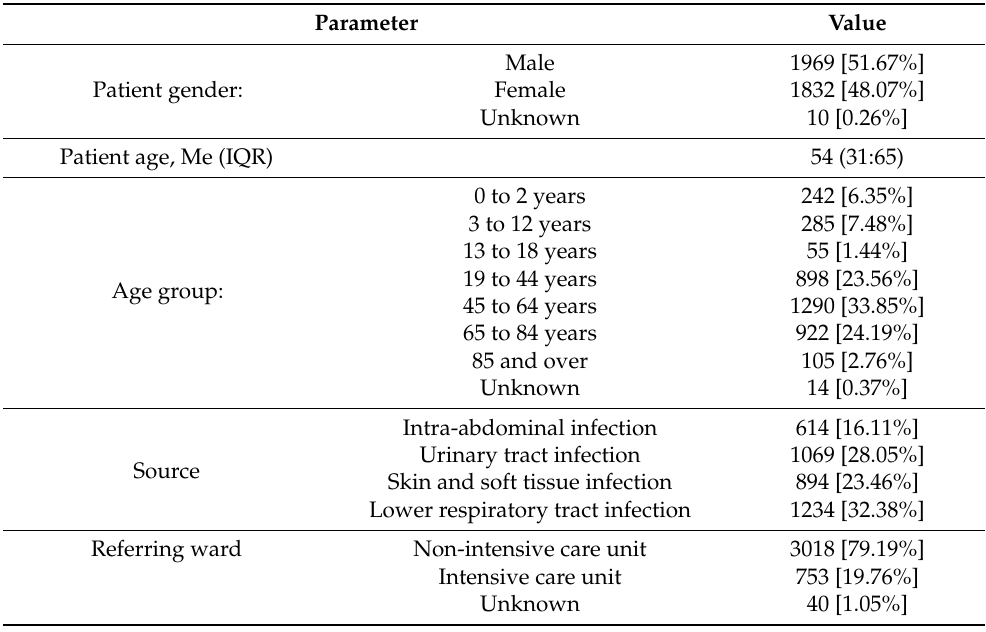
Table 1. The general characteristics of the isolates, N =